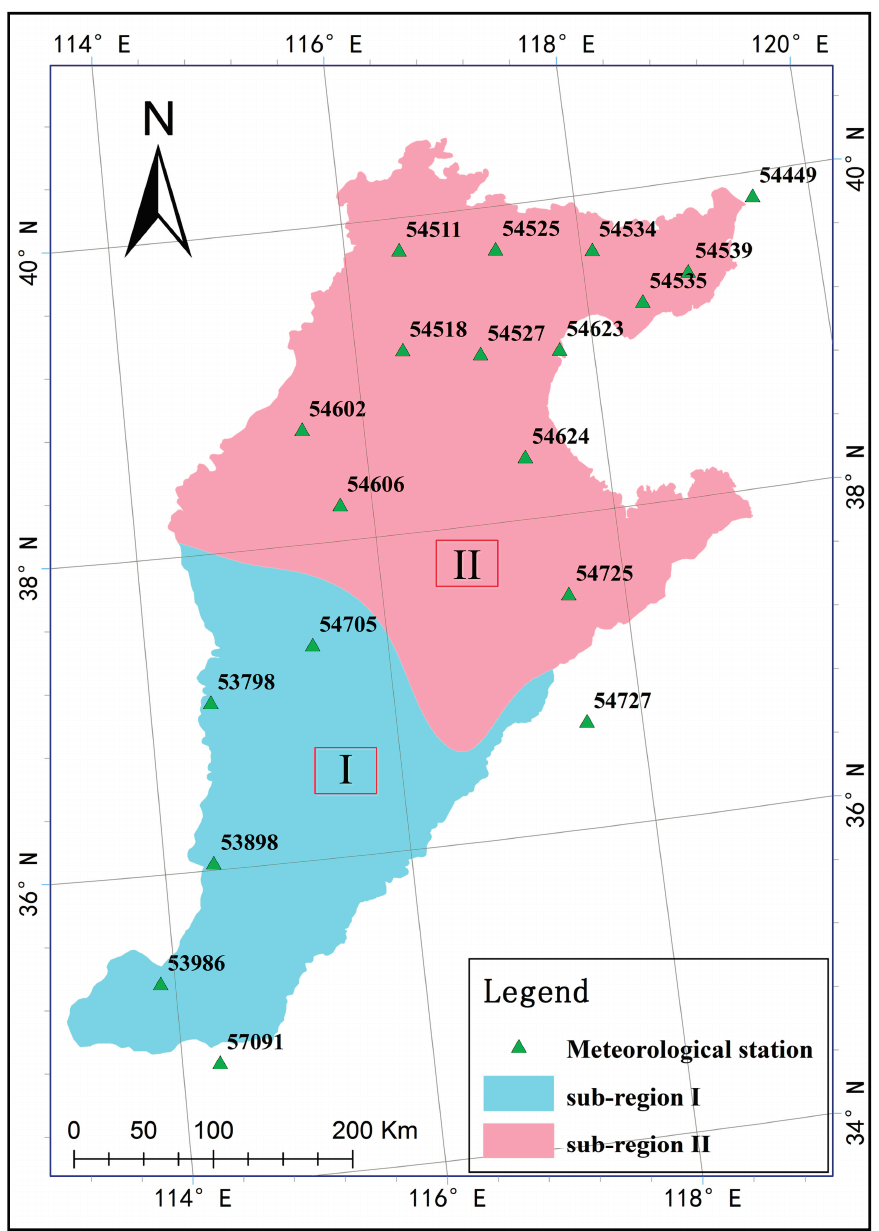
Figure 2. Identification of homogenous sub-regions in the